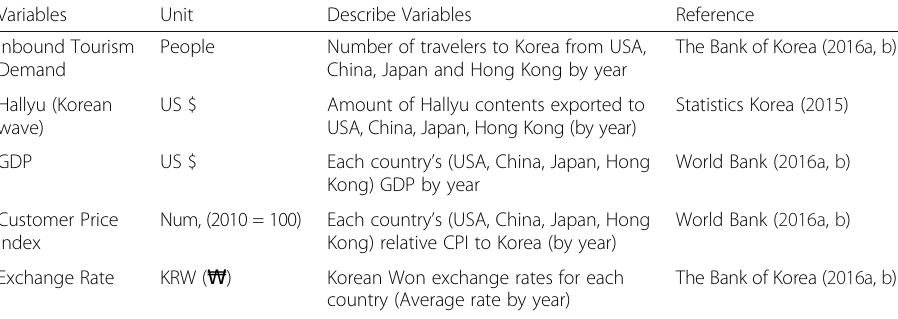
Table 1 Operational Definition of Variables Variables Unit Describe